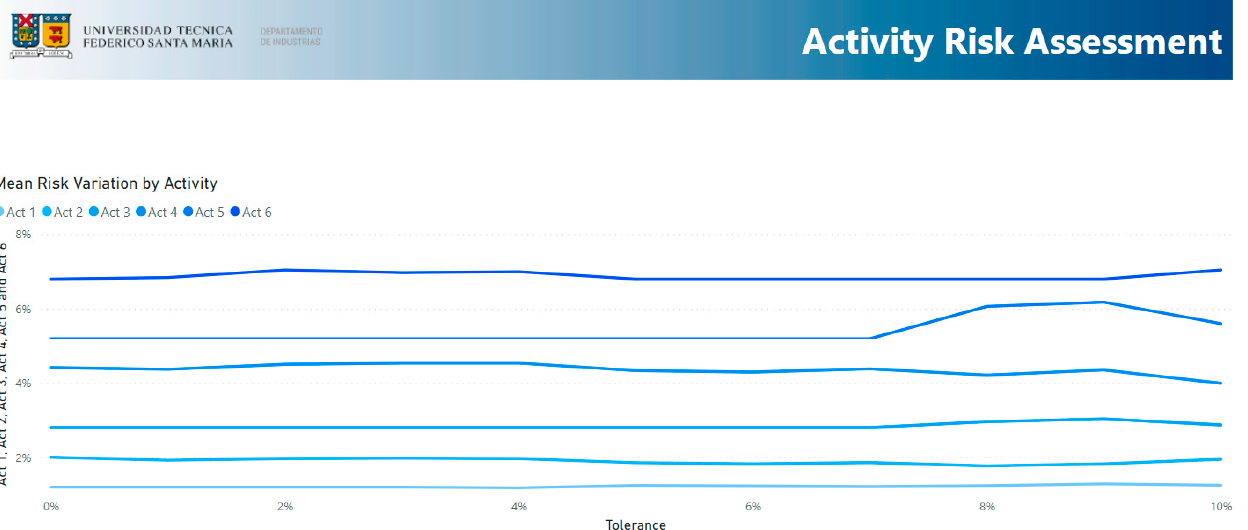
Figure 3. Best ‐ performing strategies section.